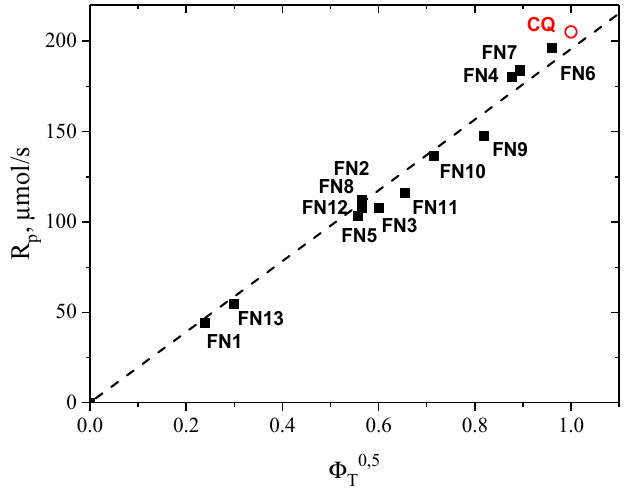
Figure 11. Correlation between the rate of photoinitiated polymerization of TMPTA and the square root of the quantum yield of the triplet state formation for FN1–FN13 and ○ –CQ in the presence of MKTFO co-initiator (0.1 M); the light intensity of diode laser (408 nm) was 18 mW/cm 2.